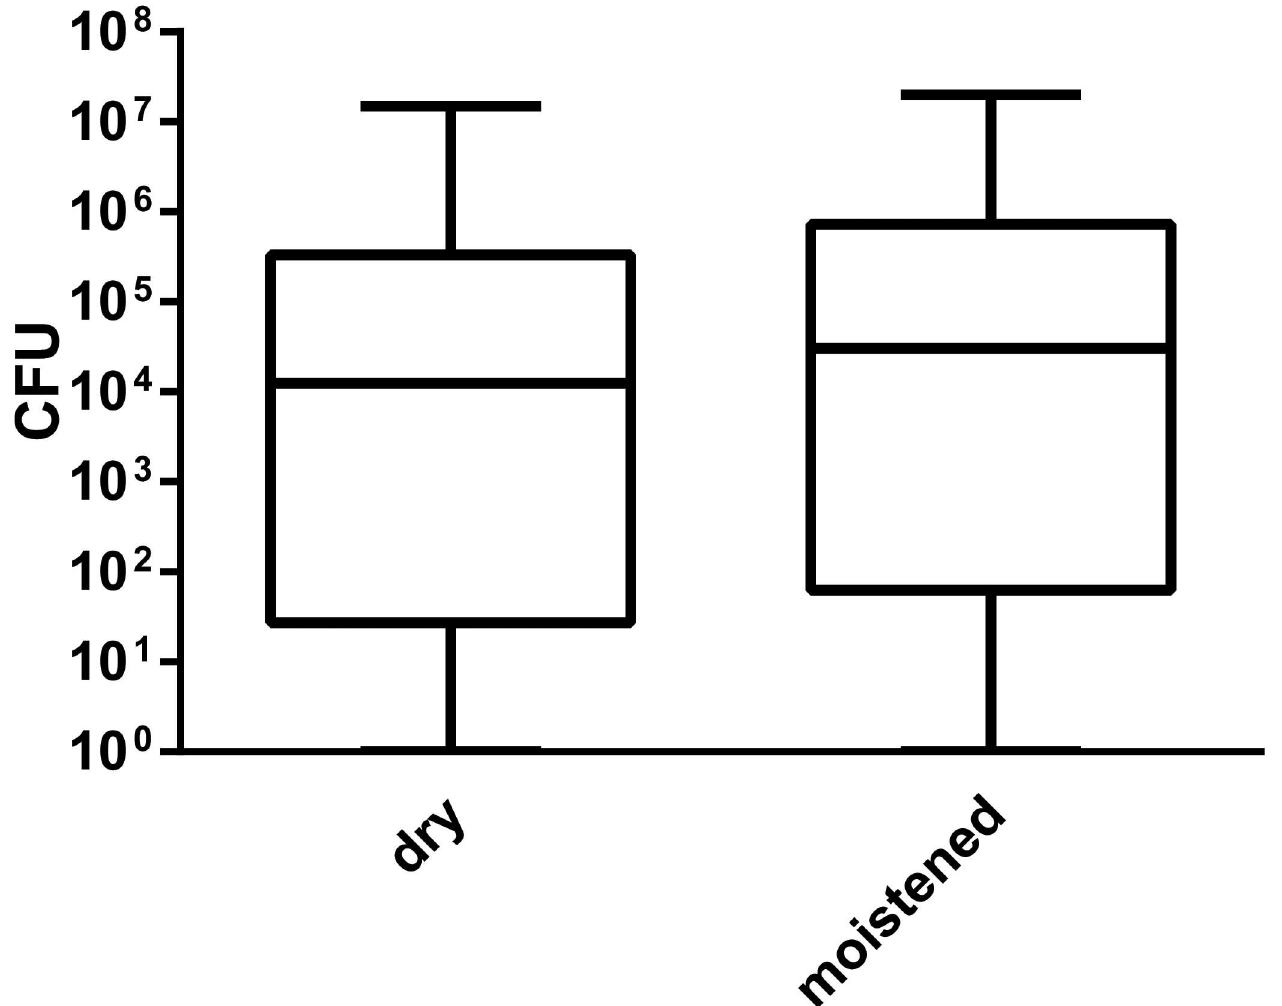
Fig 1. RecoveredMRSA quantities from patientsutilizingdry or moistenedrayon swabs. Patients were swabbed in the nostrilsutilizing eitherdryor moistrayon swabs. CFU = colony formingunits. Data resultfromn = 135 patients.p-value = 0.17 (Wilcoxon-Mann-Whitney